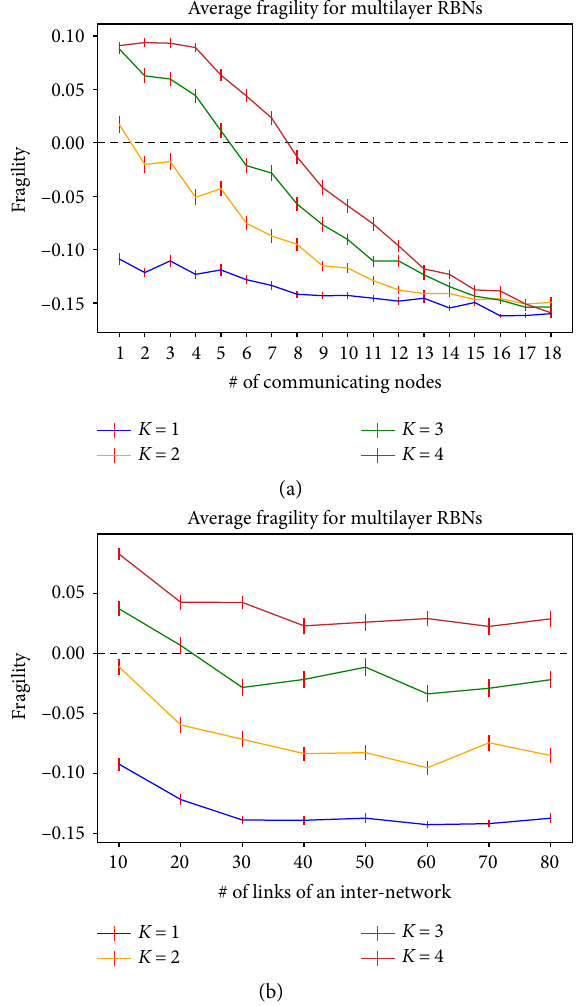
Figure 5: Average fragility of ordered, critical, and chaotic multilayer RBNs depending on two parameters related to the multilayer structure. (a) Fragility against the number of communicating